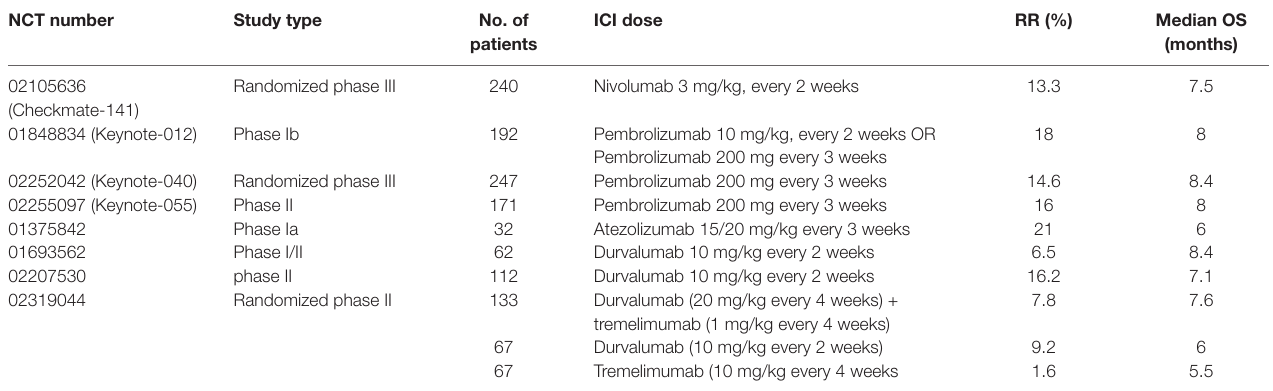
TABLE 1 | Overview of the included clinical trials of ICIs in